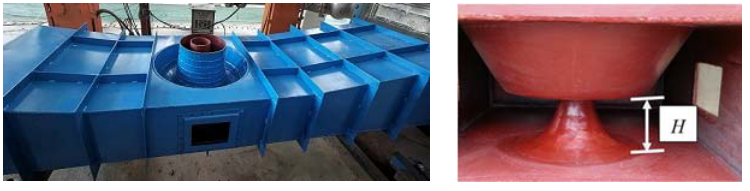
Figure 4. Photos of model intake.